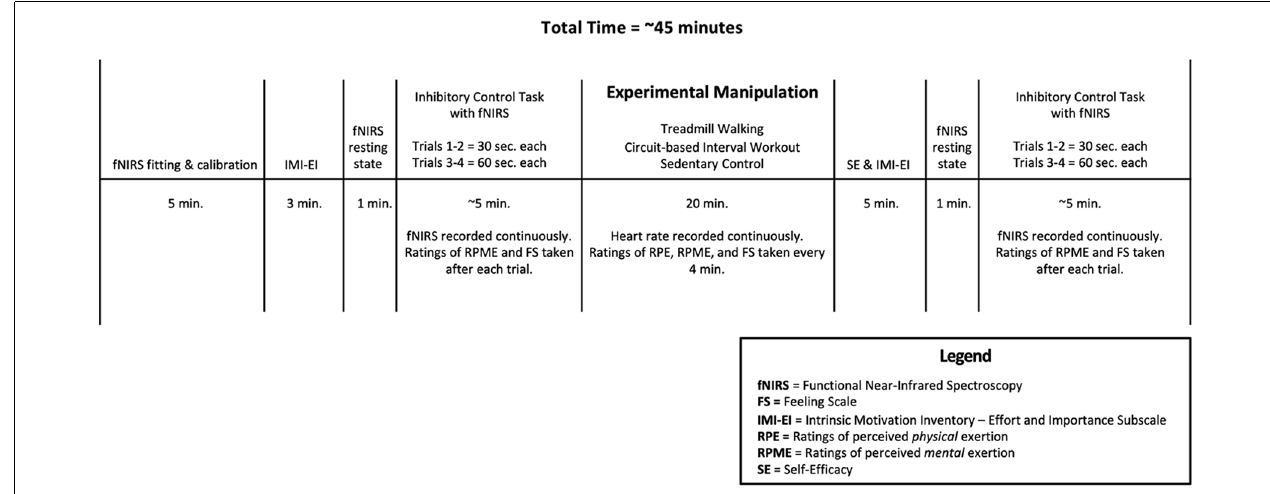
FIGURE 1 | Study protocol.